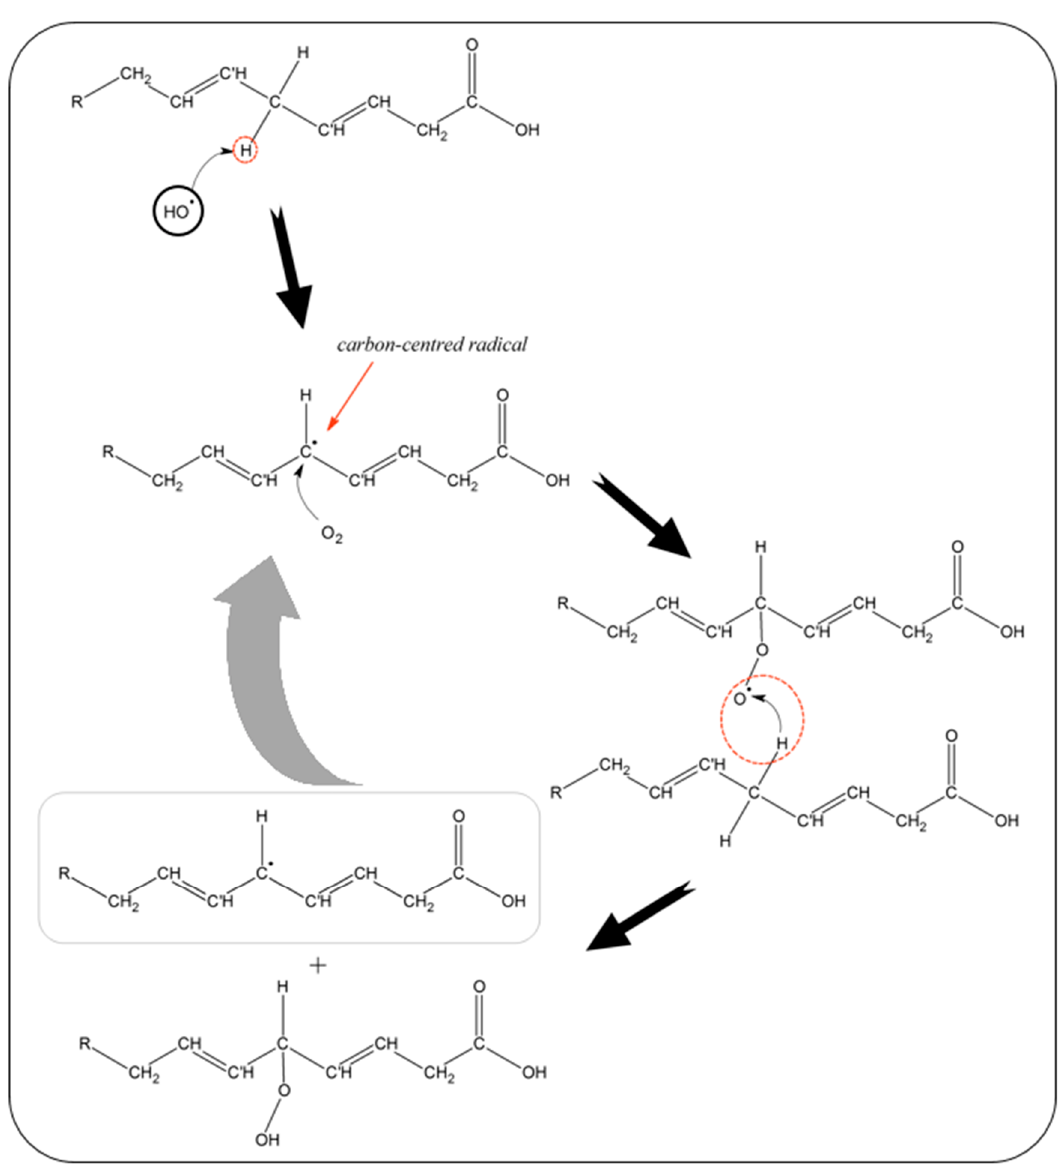
• OH) over lipid chain– resulting in lipid Figure 8. Reactivity of hydroxyl radical ( 𝑂𝐻  ) over lipid chain– resulting in lipid peroxidation. Figure 8. Reactivity of hydroxyl radical (